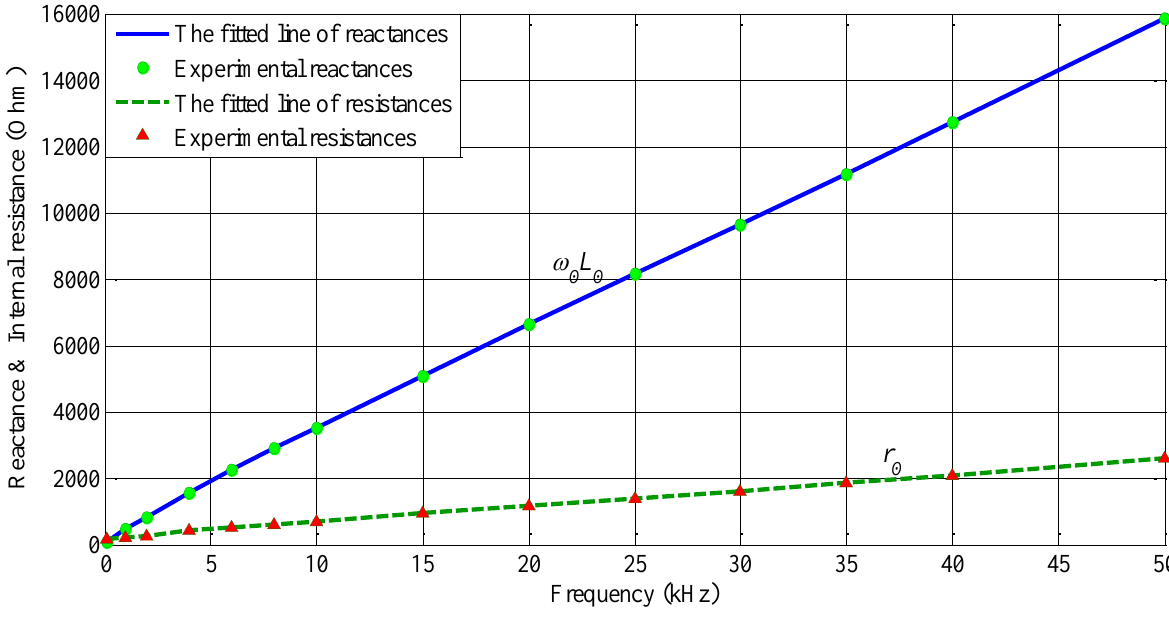
Figure 5. Frequency characteristic of inductive sensor